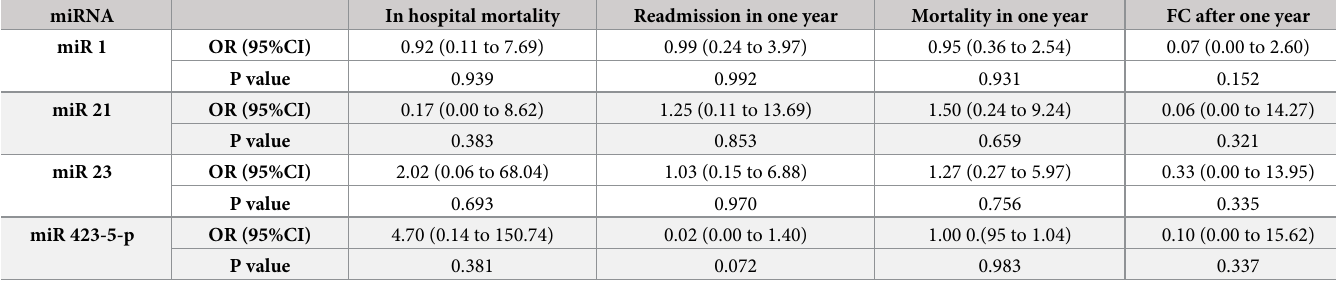
Table 3. The association between the level of miRNAs and the patients’ outcomes in follow up. miRNA In hospital mortality Readmission in one